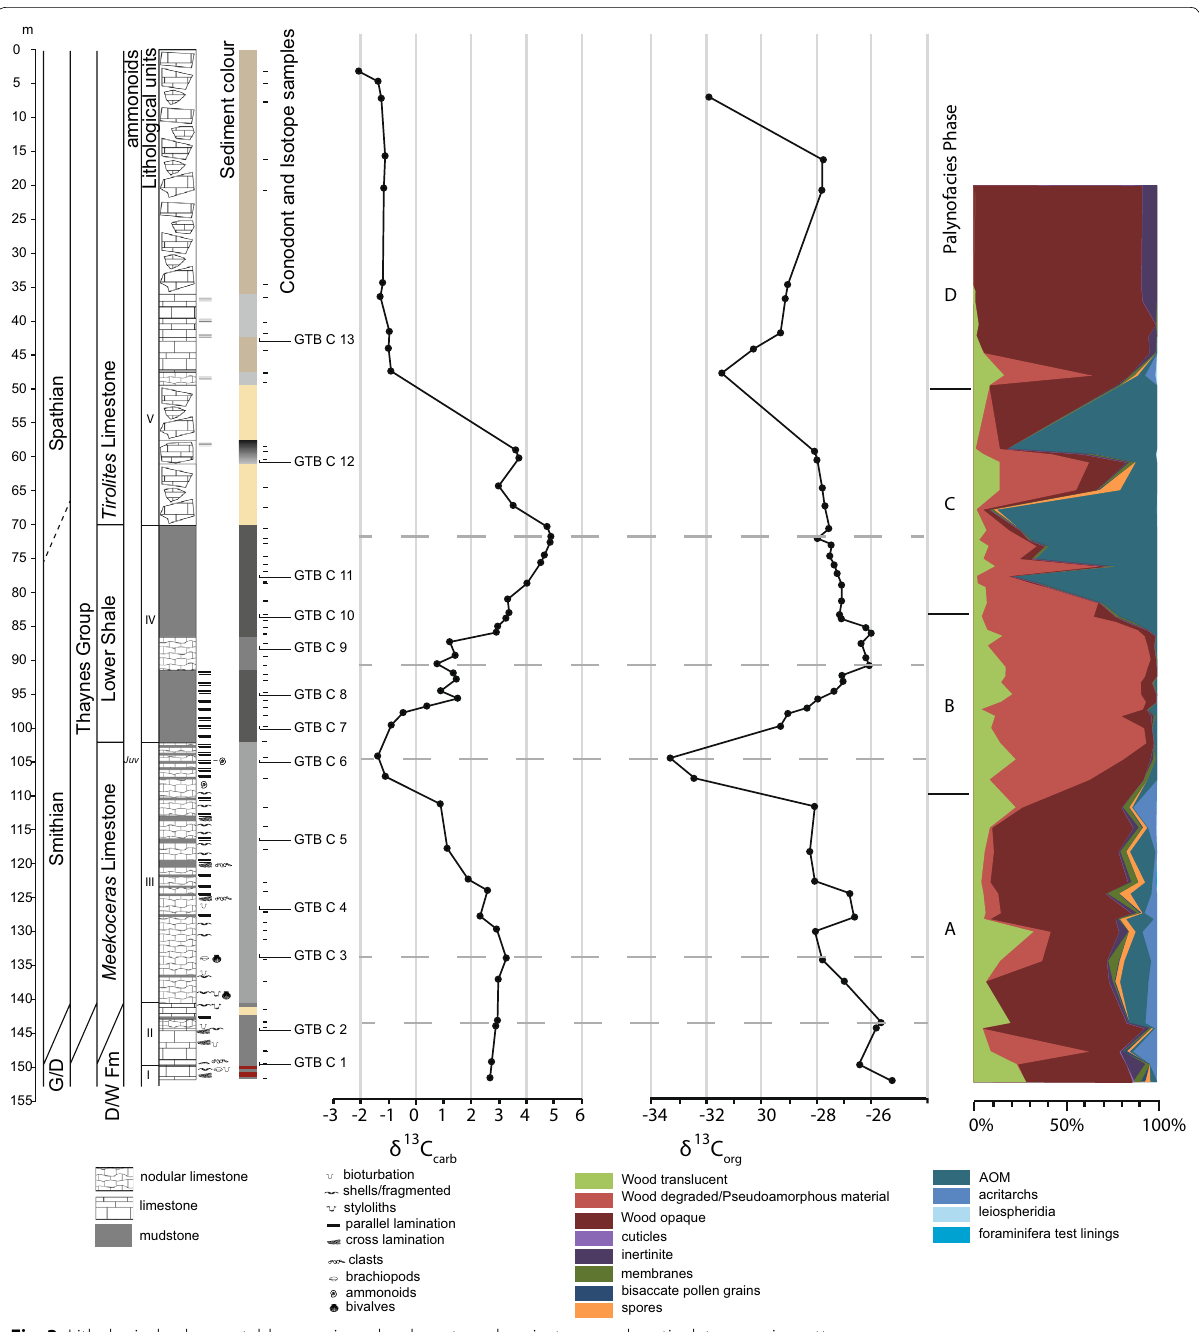
Fig. 3 Lithological column, stable organic and carbonate carbon isotope, and particulate organic